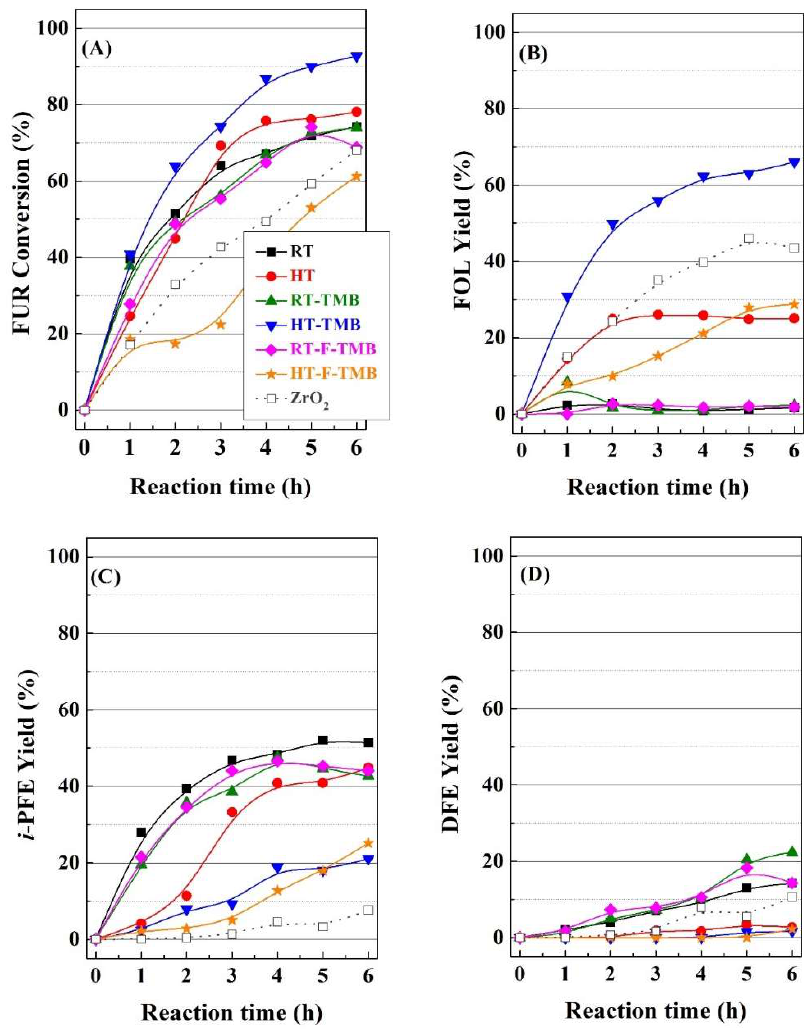
Figure 5. Furfural conversion ( A ), furfuryl alcohol yield ( B ), i -propyl furfuryl ether yield ( C ) and difurfuryl ether yield ( D ) in the MPV reaction using Zr-doped porous silica catalysts. (Experimental conditions: 0.1 g of catalyst, reaction temperature: 110 °C, i -POH/FUR molar ratio: 50, FUR/catalyst mass ratio: 1).